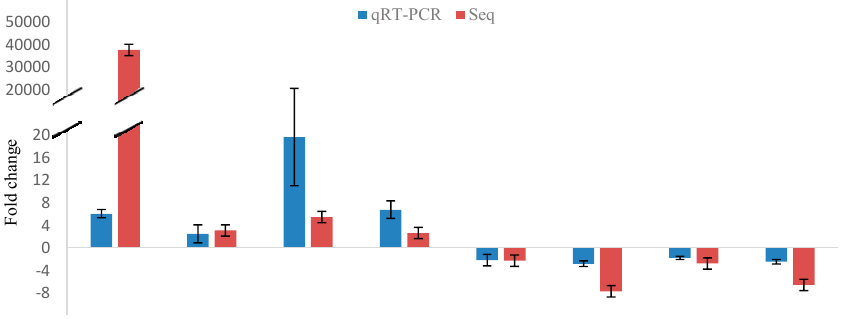
Figure 3. Confirmation of deregulated miRNAs in Lin − cells by qRT-PCR compared with sequencing. The data are presented as the mean ± SD. n = 6 for each group.